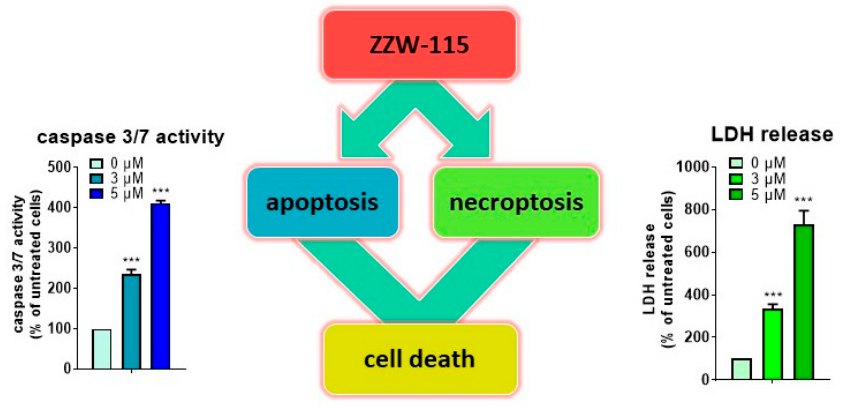
Figure 2. ZZW-115 is a promising therapeutic agent inducing tumor cell death by necroptosis and apoptosis. Treatment with ZZW-115, at a concentration of 3 or 5 µM for 24 h, of pancreatic cancer cells (MiaPaCa-2 cells) demonstrated that our compound was able to induce cell death by apoptosis and necroptosis on a dose-dependent manner, by measuring caspase 3/7 activity or LDH release, respectively.